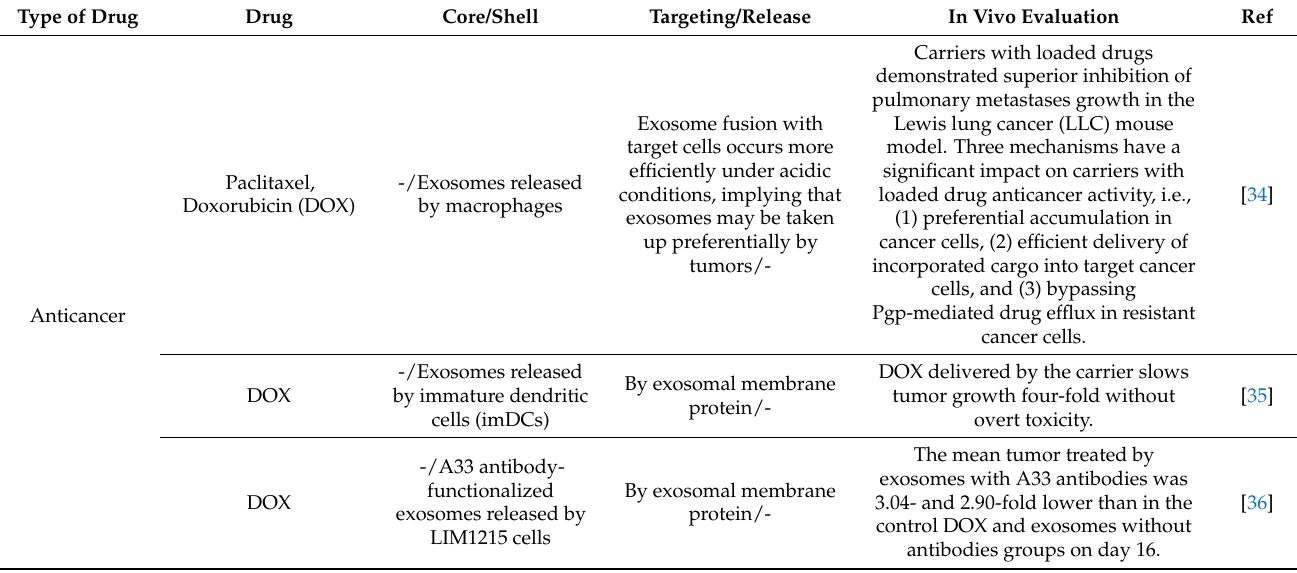
Table 1. Types of drug encapsulation systems, their targeted delivery, and payload release after their intravascular administration in